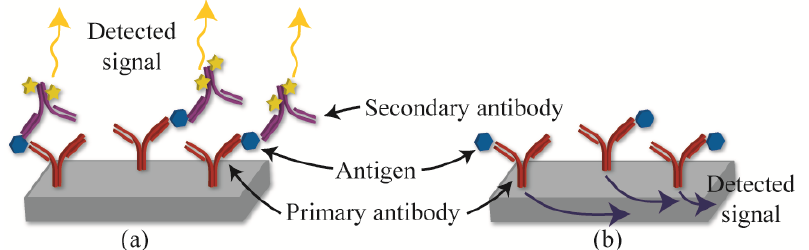
Figure 1. Comparison between ( a ) labeled and ( b ) label-free detection